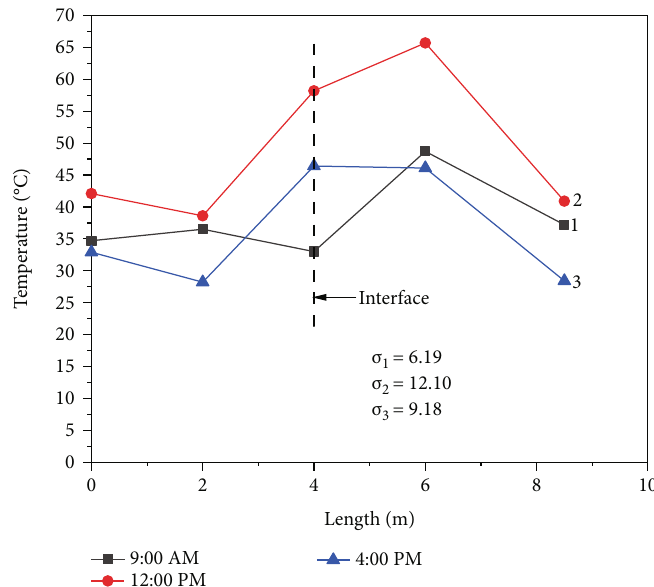
Figure 8: Temperature distribution along the length of the collector/dryer during a loading